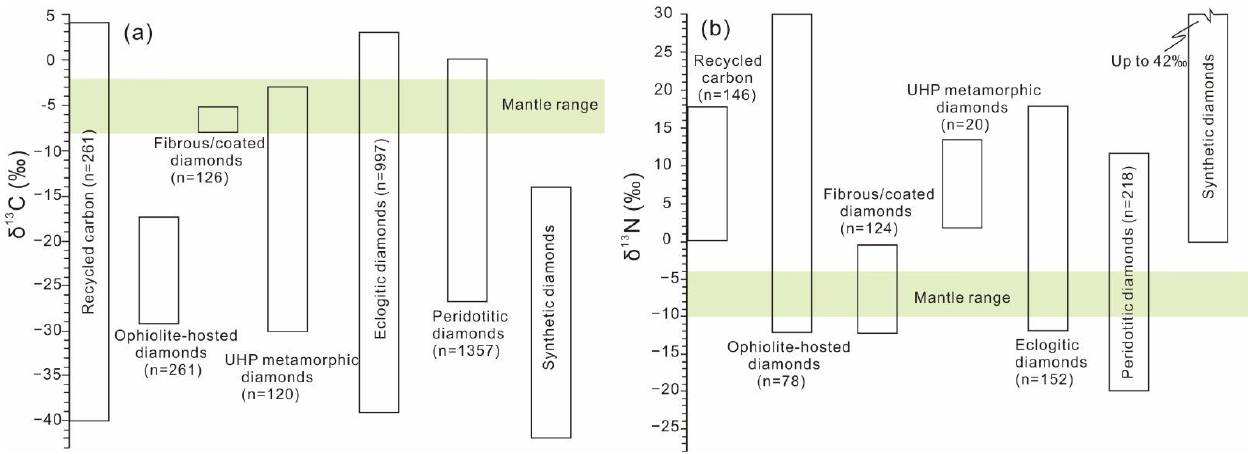
Figure 6. δ 13 C values ( a ) and δ 15 N values ( b ) for various types of diamonds and recycled carbon. Data mainly from [3,5,102,123,128,129].